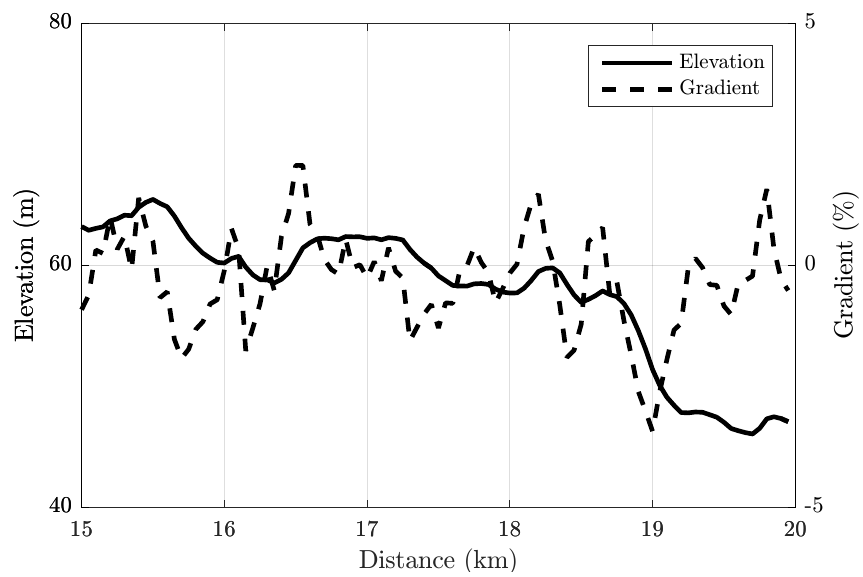
Figure 11. Test road section profile with elevation (left axis) and gradient (right